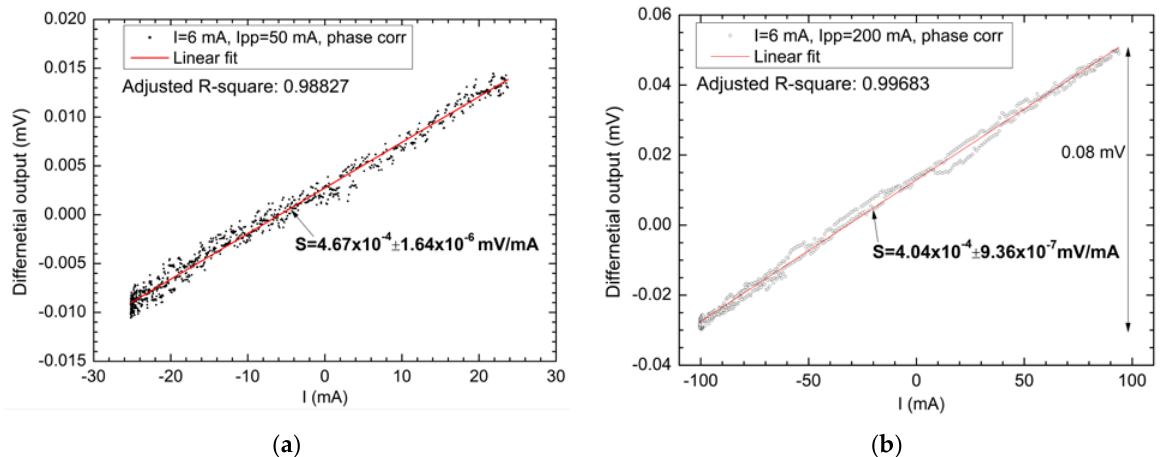
Figure 22. Response characteristics of the differential sensor, depending on the value of the current through the printed Ag trace for: ( a ) Low currents up to 25 mA; ( b ) Currents up to 100 mA.